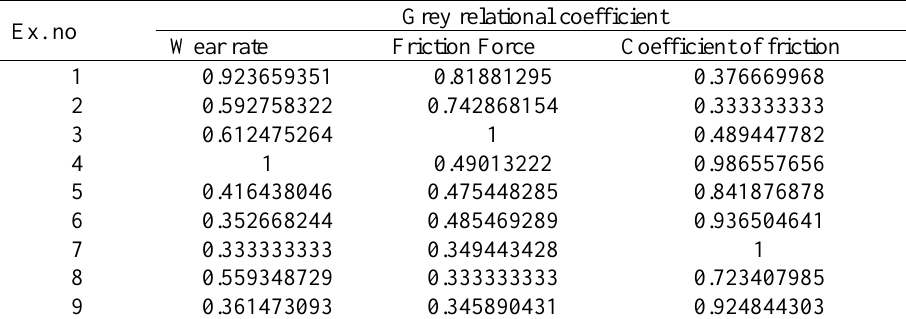
Table 5. Grey relational co-efficient.